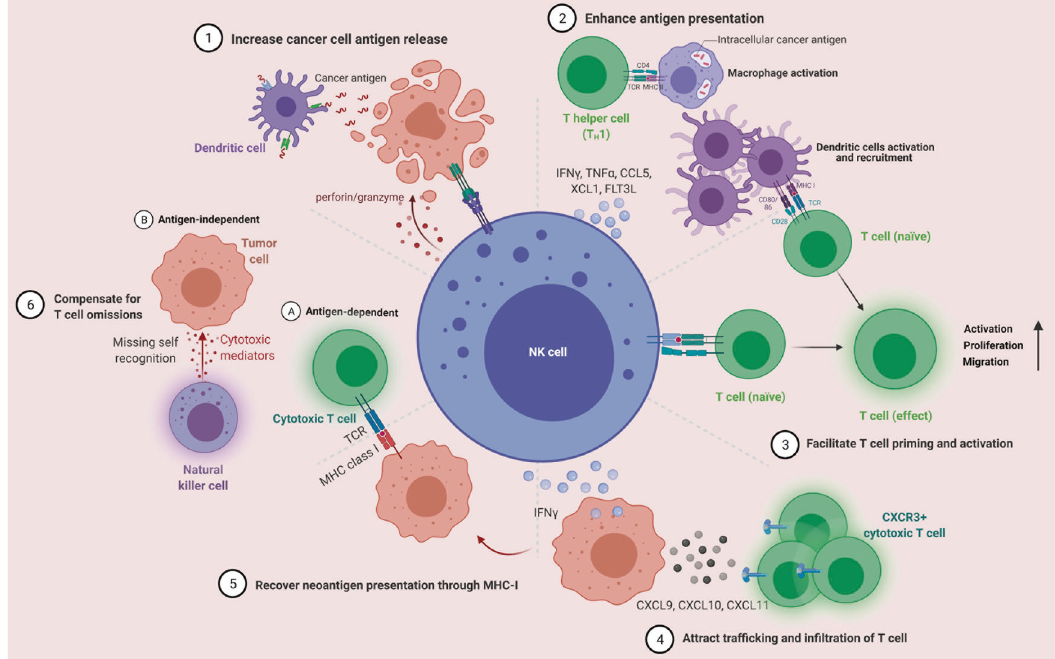
Fig. 1 NK cells are activated to impacting almost every step of cancer-immunity cycle. Activated NK cells increase cancer cell antigen release, enhance antigen presentation, facilitate T cell priming and activation, attract T cell traf fi cking and in fi ltration, recover neoantigen presentation and compensate for T cell